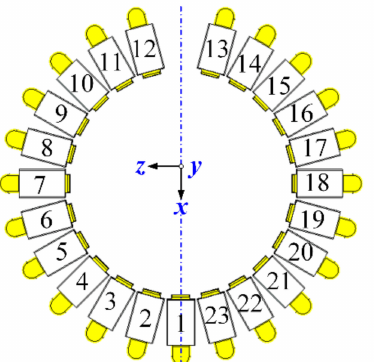
Figure 17. Arrangement of the 23 discharging bricks and the corresponding brick number. Table 2. Equivalent inductances of di ff erent discharging bricks when simultaneous discharged. Brick No. Total Inductance (nH) Self-Inductance